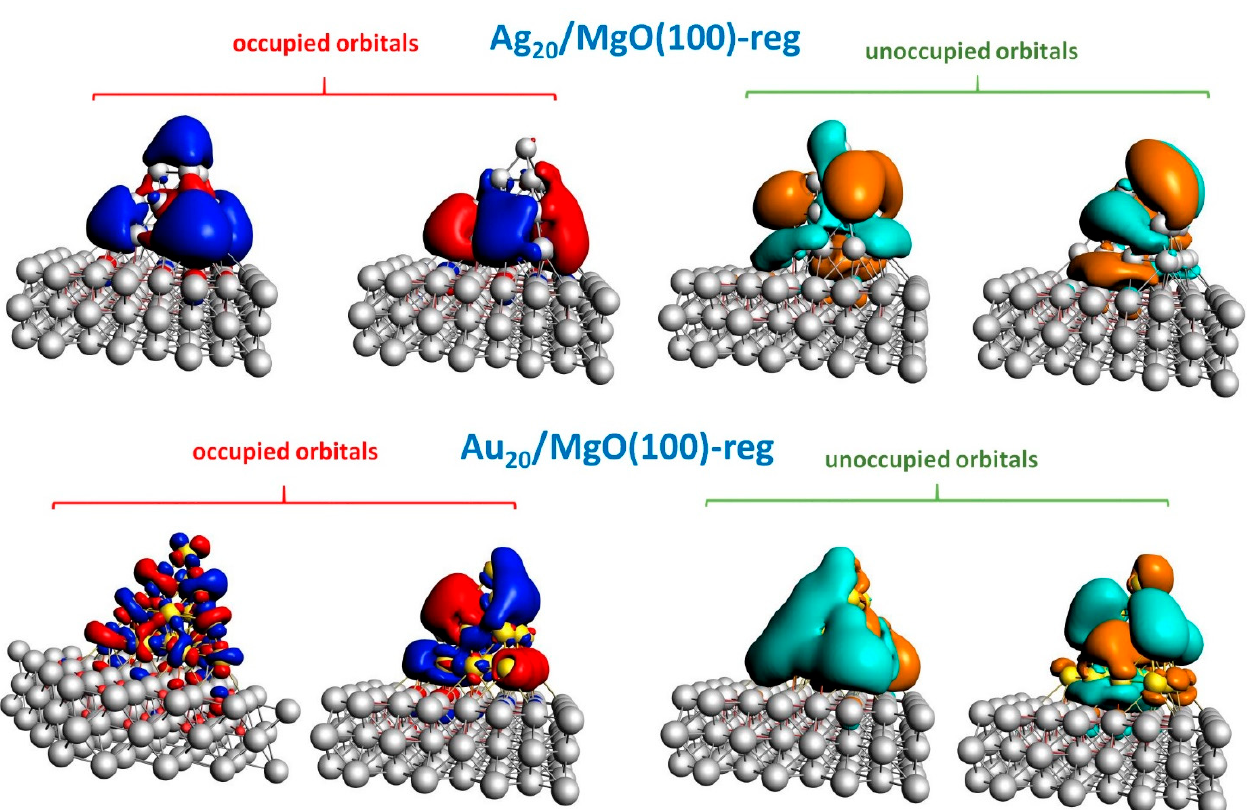
Figure 5. Contour plots of the Molecular Orbitals (MOs) of Ag 20 /MgO(100)-reg and Au 20 /MgO(100)-reg systems simulated using the ADF code. MO energy increases from left to right. Isosurfaces are set to contour values of 0.01 Å − 3/2 .